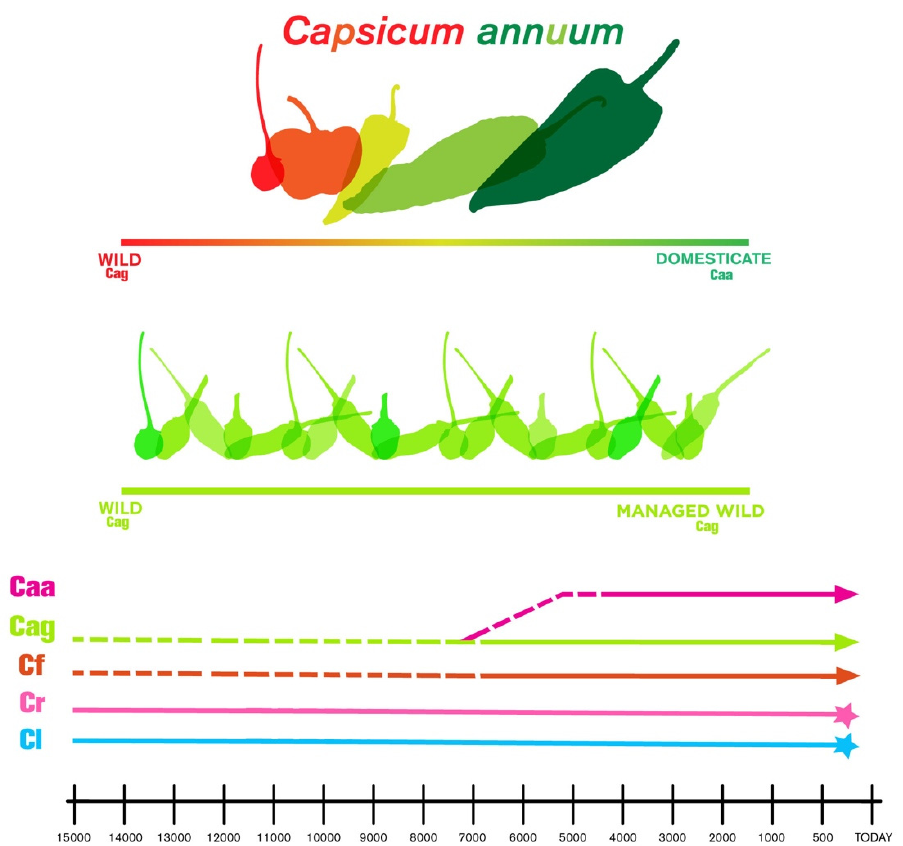
Figure 2. Model of human management of chile in Mexico. C. lanceolatum (Cl) and C. rhomboideum (Cr) were never utilized by humans (blue and pink ending in a star); C. frutescens (Cf) that includes wild and domesticates; C. annuum var. glabriusculum (Cag) are the wild chile and putative ancestor of Caa, and C. annuum var. annuum (Caa) includes the modern domesticated landraces and commercial varieties.